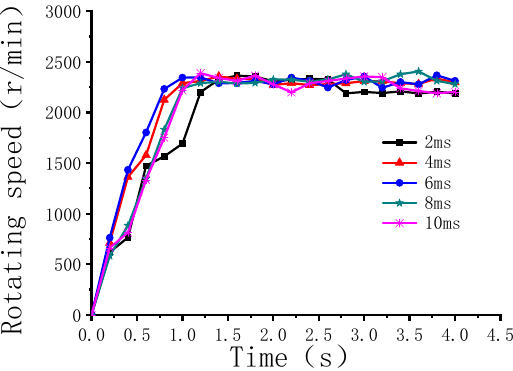
11 of 23 Figure 14. Engine cold-start time under different enrichment coefficients. Figure 13 shows that when the concentration factor is 1, the flameout is caused by an insufficient oil supply, and the engine can be successfully started when the concentration factor is 1.5 and above. Figure 14 shows that as the concentration coefficient increases, the time needed for the cold start gradually decreases. When the concentration reaches a cer- tain level, the effect on the start time decreases, and the fuel consumption increases. There-